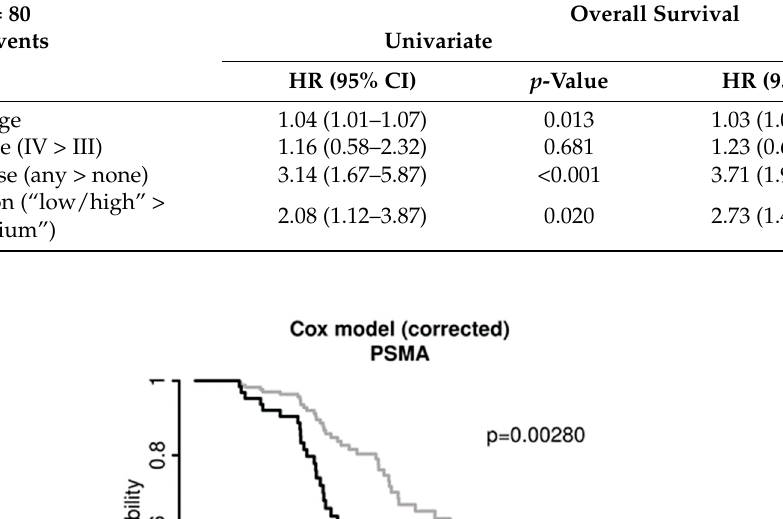
Table 3. Overall survival, univariate, and multivariate analyses. Table 2. Progression-free survival, univariate, and multivariate analyses.